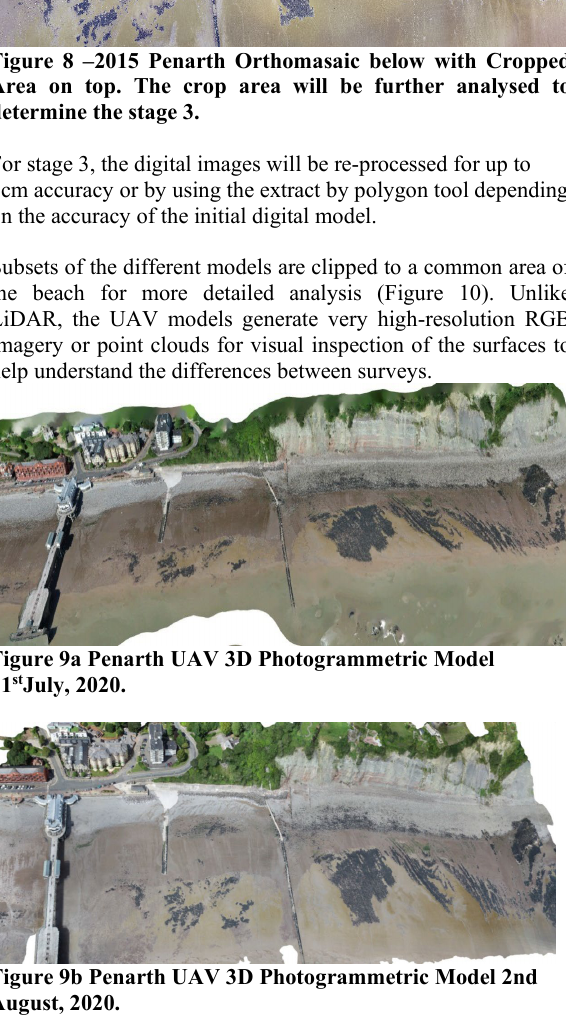
Figure 5 – Trajectory Showing the Flight Path Pattern of the Penarth Survey in 2015 together with the corresponding Orthomosaic.